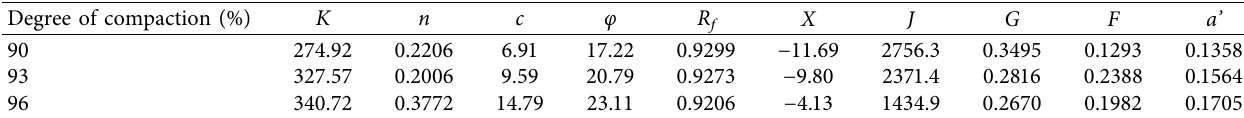
Figure 9: Relationship between ] 0, i and lg ( σ 3 / p a ). Table 2: Nonlinear constitutive model parameters based on logarithmic